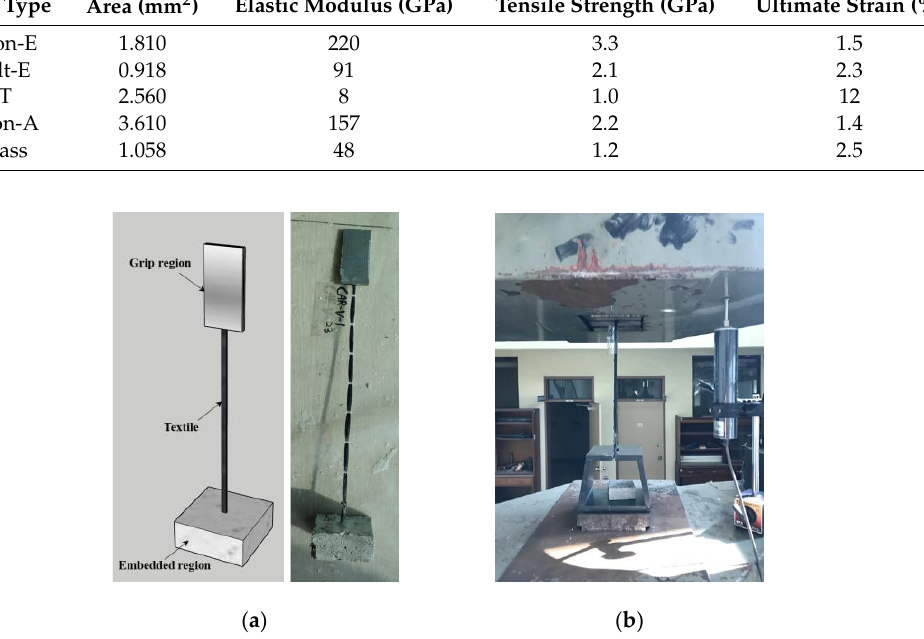
Figure 4. Test of pull-out series: ( a ) pull-out specimen; ( b ) setup of pull-out specimen.